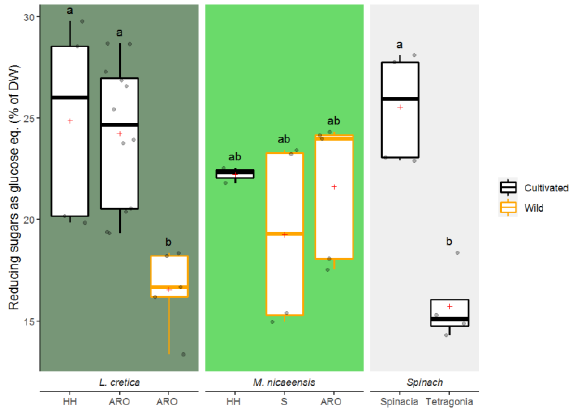
Figure 8. Reducing sugar content in leaves of two Malvaceae species and two spinach species. Different lowercase letters indicate significant differences between populations of green leaves ( p < 0.05). Species names and abbreviations of locations are given in the lower line. HH = Havat Hanoi, ARO = research site at the Agricultural Research Organization; S = agricultural area near Sandala village, North Israel. Box plot color indicates “ Cultivated ” in an agricultural field, or “ Wild ” , grown wildly at field margins or feral fields. Median and average are indicated as a horizontal line within the box plot and red cross, respectively, and gray dots denote results of single analyses.